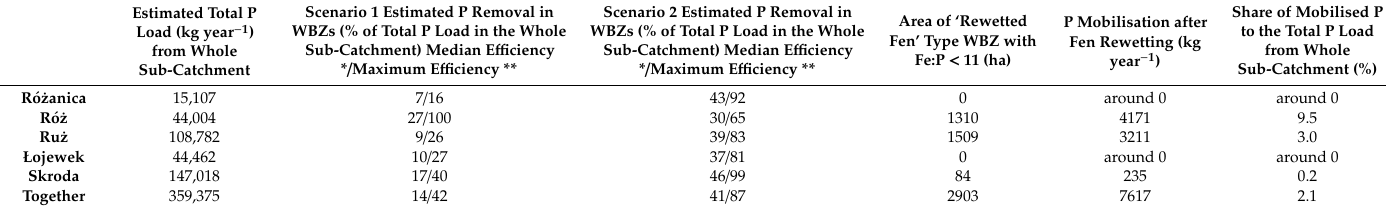
Table 3. Phosphorus load and removal.